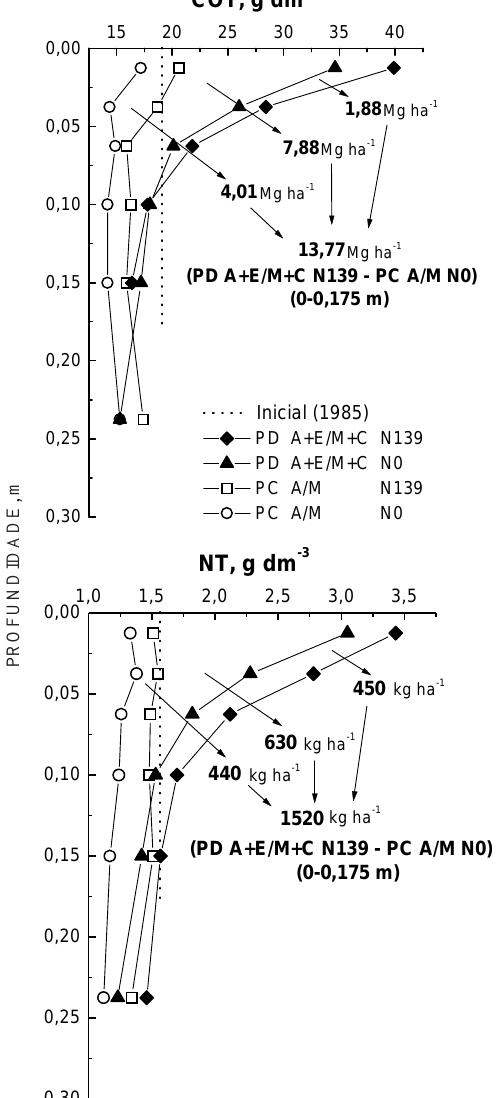
Figura 4. Distribuição dos teores de carbono orgânico total-COT (a) e de nitrogênio total-NT (b) no perfil do solo no início do experimento (1985) e 13 anos após, nos tratamentos com situações extremas de revolvimento do solo e de adição de N. PC = preparo convencional, PD = plantio direto, A = aveia, M = milho, E = ervilhaca, C = caupi.